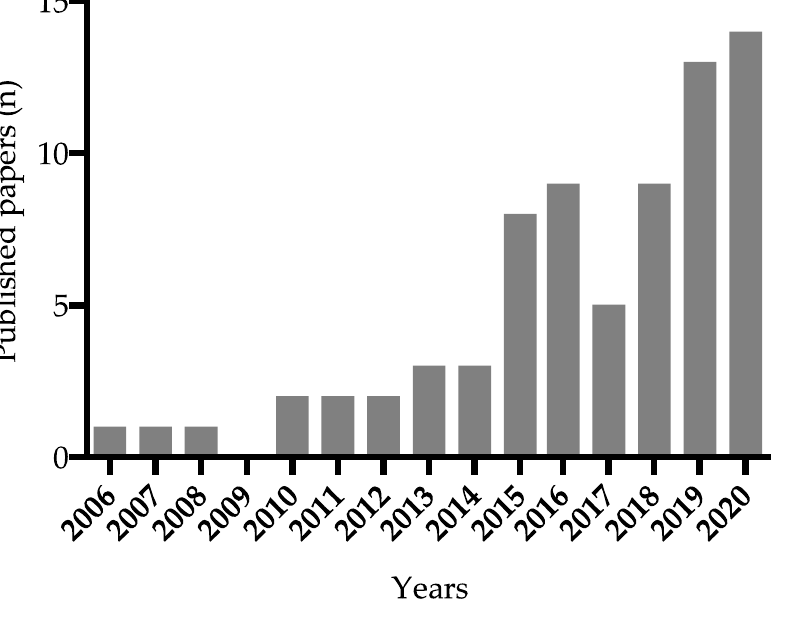
Figure 1. Research articles per year published on biostimulants from cyanobacteria since 2006. The bibliometric analysis was carried out using the Google Scholar database, searching for “cyanobacteria + biostimulants”, “microalgae + biostimulants”, and “cyanobacteria + plant growth promotion” and excluding articles where the action was predominantly as biofertilizer.